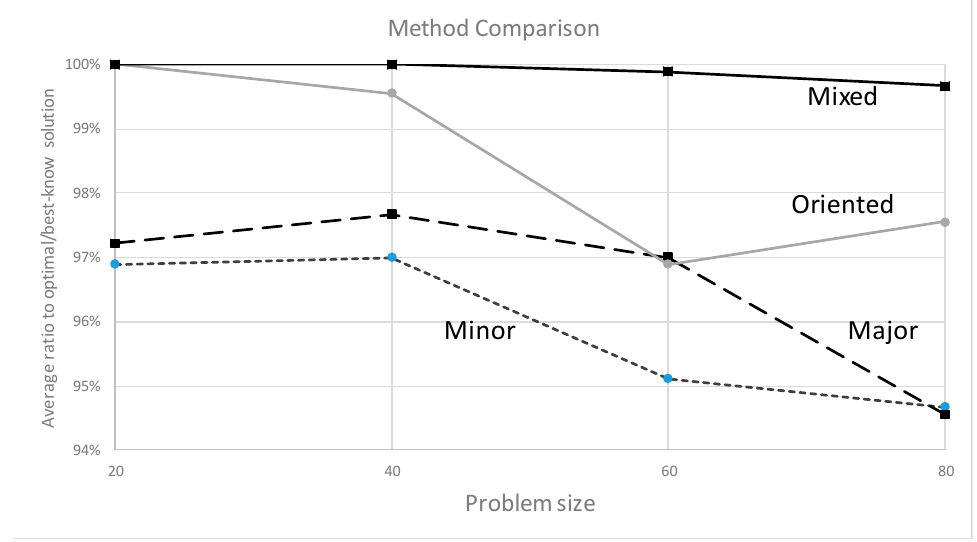
Figure 8. Comparison.